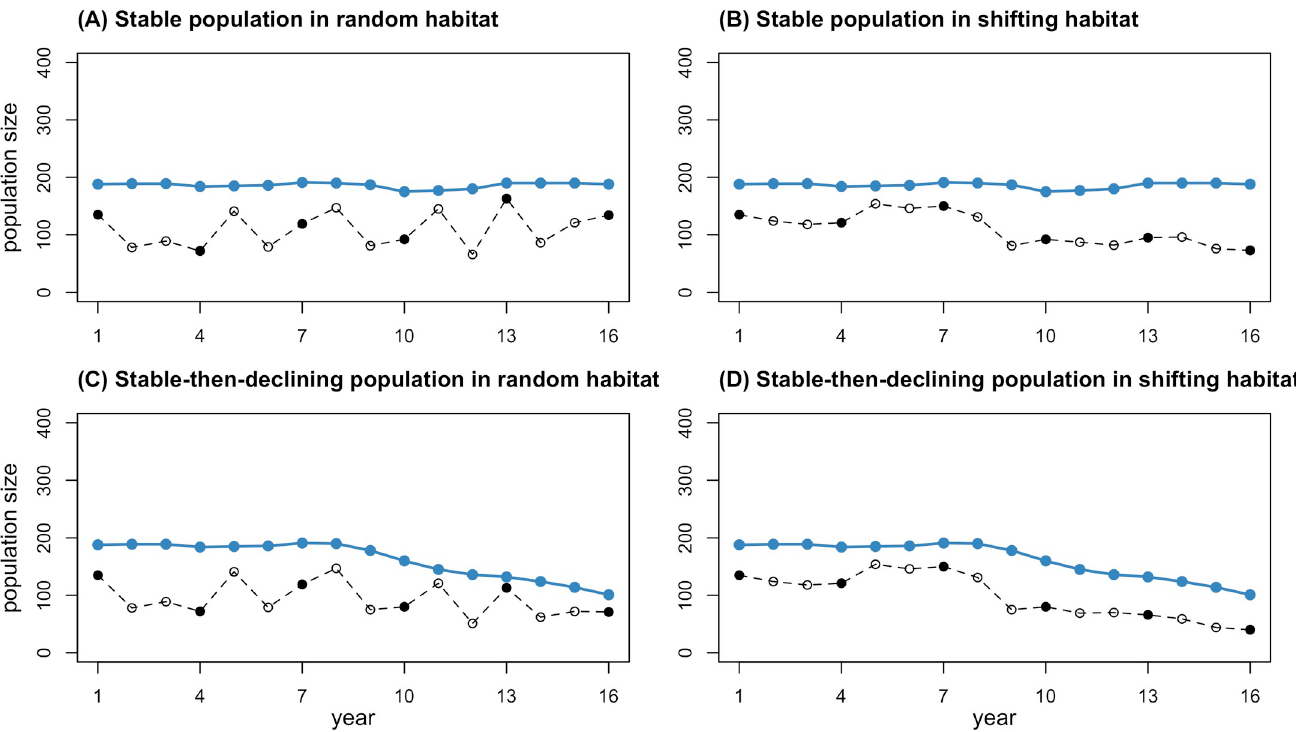
Fig 2. Population trajectories under the four contrasting scenarios over the entire range and in the survey region. Blue points indicate the true population size over the entire range in each scenario. Open black points indicate the number of individuals in the survey region in each scenario, with filled points for survey years.